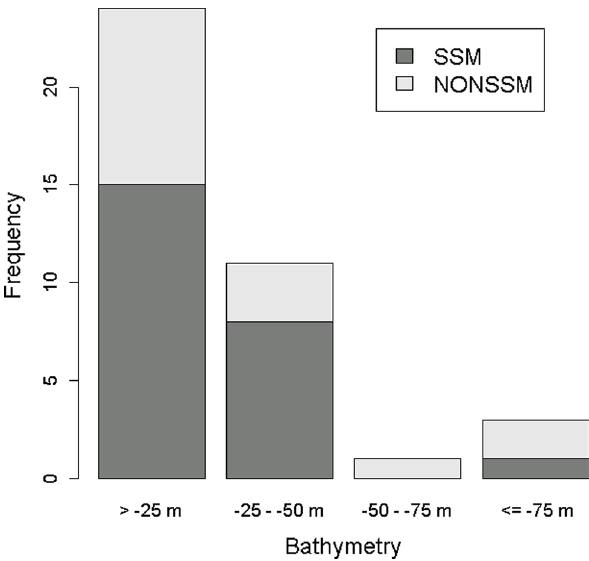
Figure 5. Bathymetry histogram for locations used by satellite- tagged loggerheads ( Carettacaretta ; n=39 individuals) in the Northern Gulf of Mexico, 2011–2012. SSM=turtles for which state- space modeling was successful (n=24); NONSSM=turtles for which SSM was not possible (n=18).